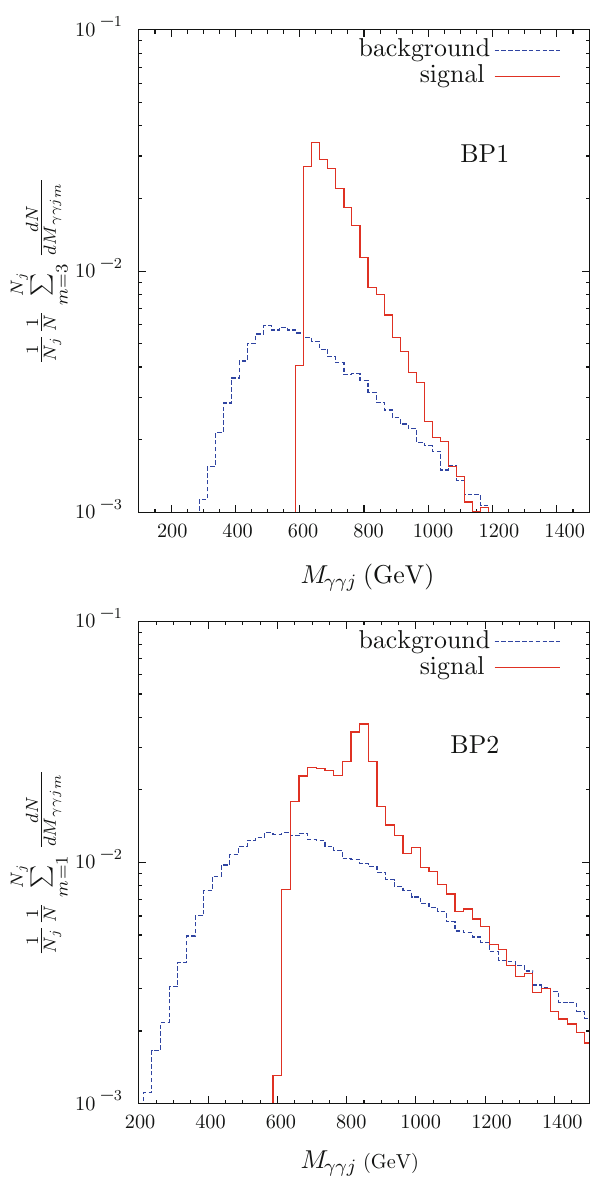
Fig. 6 The average of normalized invariant mass distributions of the leading two photons with a jet. The average for BP1 starts from the third leading jet and the average for BP2 starts from the first leading jet